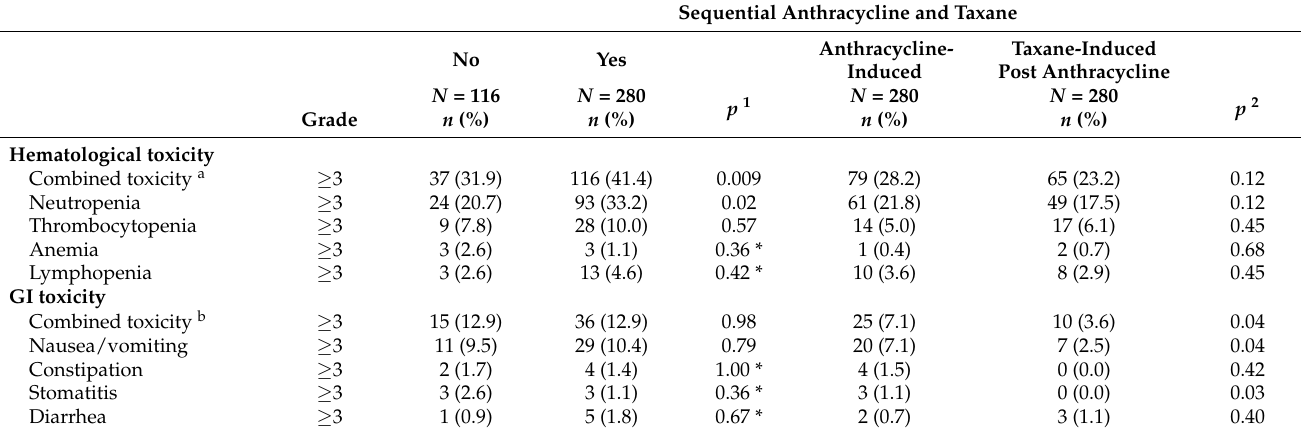
Table 1. Incidence of grade ≥ 3 chemotherapy-induced toxicities by sequential anthracycline and